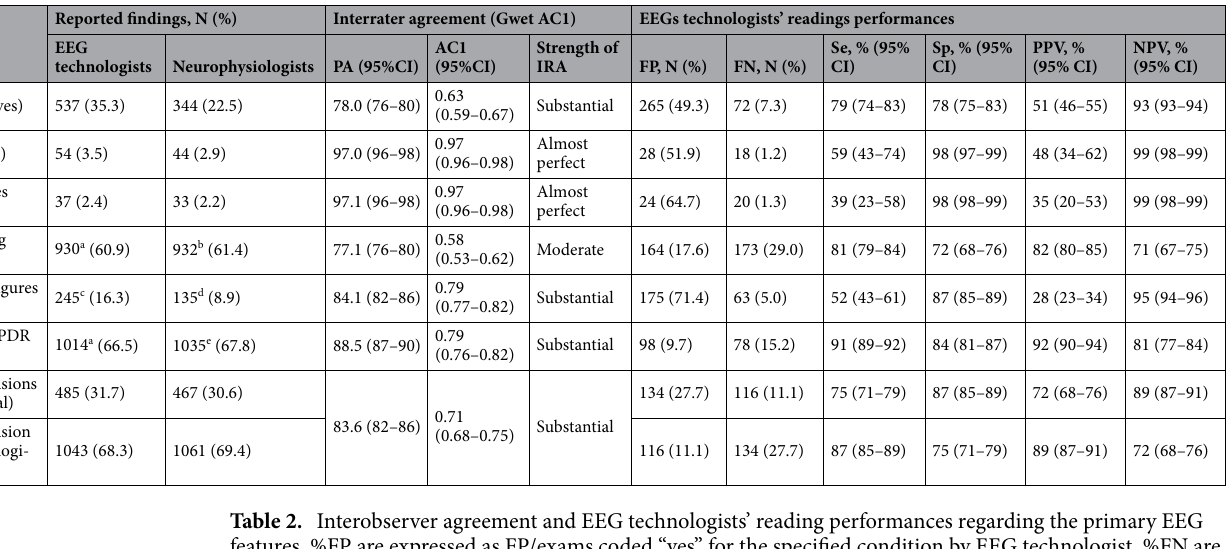
was associated with lower global conclusion rates. EEG indication (primary epileptic versus non-epileptic) and patient´s gender did not appear to affect the various studied parameters. Among the 725 patients with epilepsy diagnoses, epilepsy etiology did not influence seizure detection or the assessment of PDR or slowing. However, epilepsy etiology significantly altered the SE detection agreement rate (p = 0.002, significant after correction for multiple comparison), with neurophysiologist and EEG technologists presenting 97.8% agreement (n = 81) for patients with genetic epilepsy, 99.5% (n = 194) for patients with epi- lepsy of unknown etiology, and 94.6% (n = 421) among patients with symptomatic epilepsy. Global conclusion